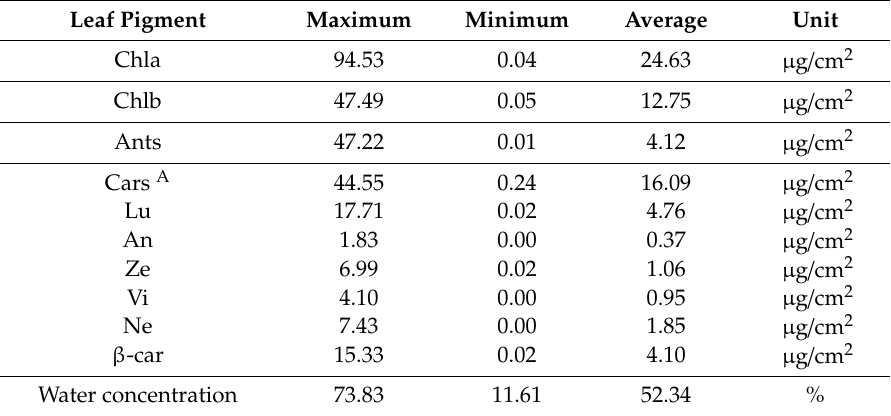
Table 1. Leaf biochemical measurement for the ZJU